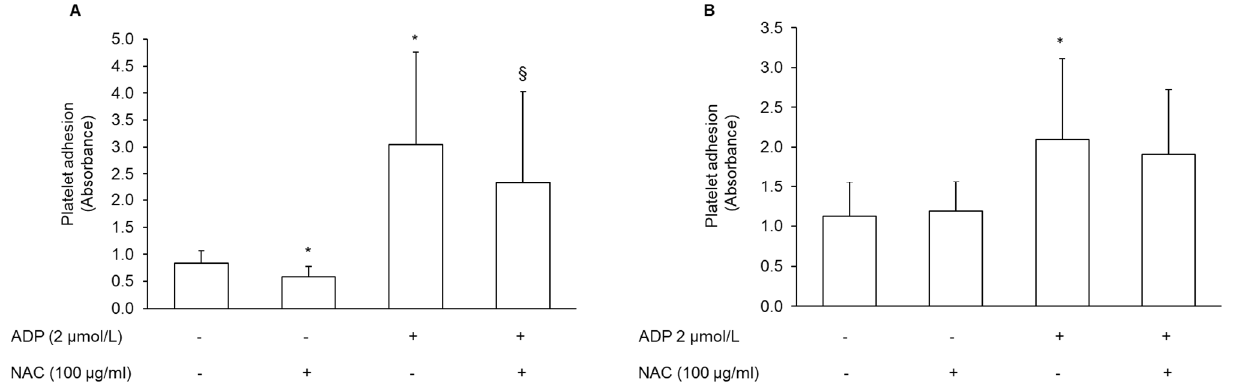
Figure 6 . Effect of NAC on platelet adhesion to extracellular matrices. PRP was incubated with vehicle or NAC for 30 min at 37 °C, and added to ( A ) collagen- or ( B ) fibrinogen-coated plates. Platelets were incubated for 1 h at 37 °C. Non-adherent platelets were removed, and the adherent platelets were quantified through the measurement of acid phosphatase activity. Data are expressed as absorbance, n = 7. * p < 0.05 vs. basal, § p < 0.05 vs. ADP-stimulated platelets for the Student t -test in the comparison of the NAC-treated sample vs. the respective sample without NAC.